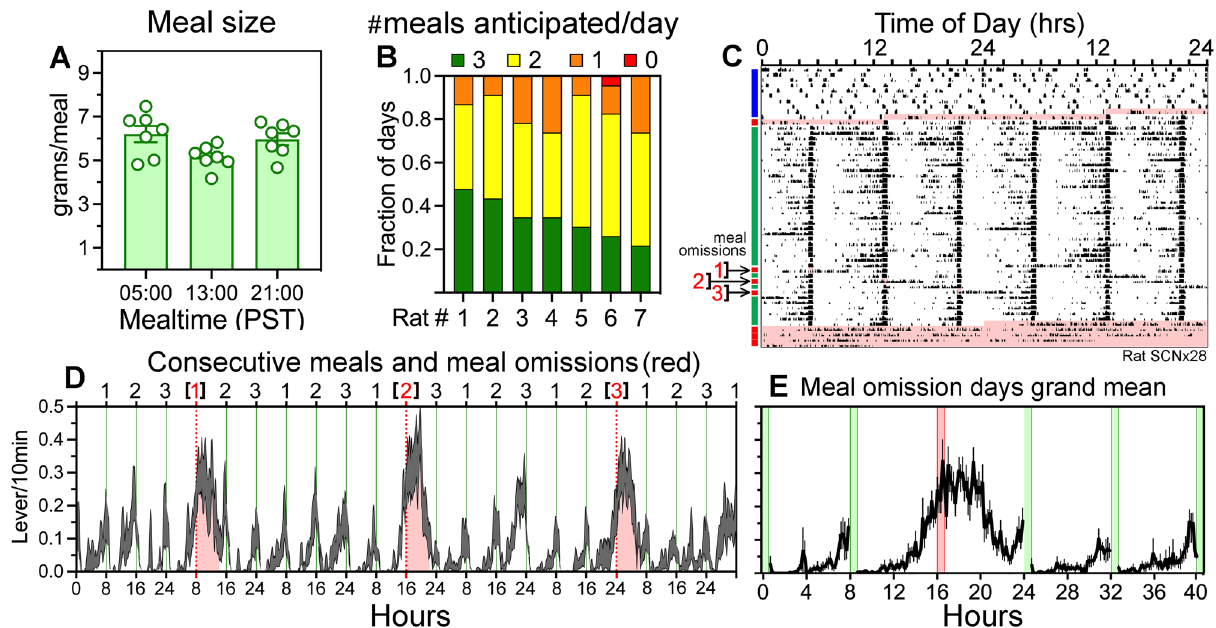
Figure 3. Meal omission tests reveal robust timing of 3 daily meals ( A ) Food intake (grams) at each mealtime (group mean ± SEM). ( B ) Fraction of food restriction days that each rat anticipated 1, 2, or 3 meals (number of meals color coded; red = 0, orange = 1, yellow = 2, green = 3). ( C ) Double-plotted actogram of lever pressing in a representative rat with a SCN lesion estimated to be 95% complete (for histology, see supplementary Fig. S9b). Food was available ad-libitum for 10 days and then restricted to 3 daily mealtimes for 40 days. On days 29, 31 and 33 (denoted by arrows on the left of the actogram) lever pressing was not reinforced during one of the scheduled mealtimes. Pink shading denotes full days of food deprivation. ( D ) Group mean waveform of lever pressing during the week of single meal omission tests. Thin vertical lines indicate scheduled mealtimes. Pink shading denotes unreinforced lever pressing associated with each of the three meal omissions. ( E ) Grand mean (± SEM) of lever pressing during all meal omission test days, generated by aligning and averaging the meal omission days for each rat, and then for the group. Green vertical bars denote mealtimes, and the red vertical bar denotes the omitted